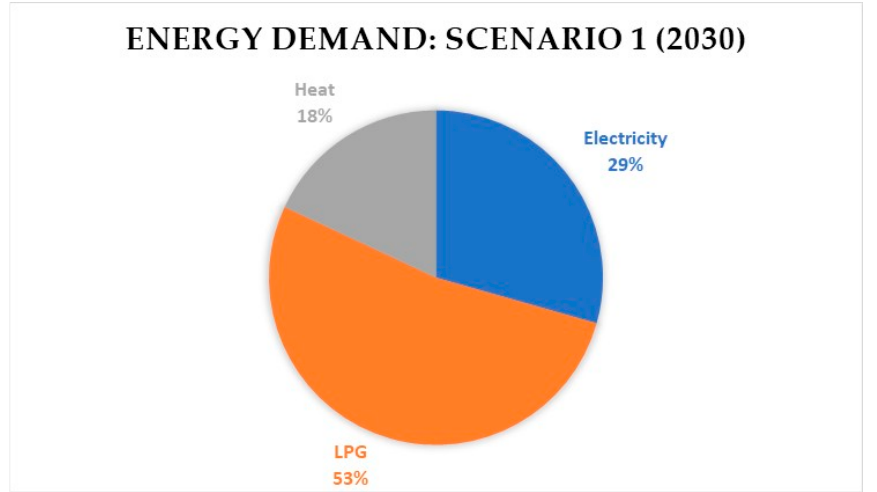
Figure 6. Scenario 1. Energy consumption in 2030, residential sector.